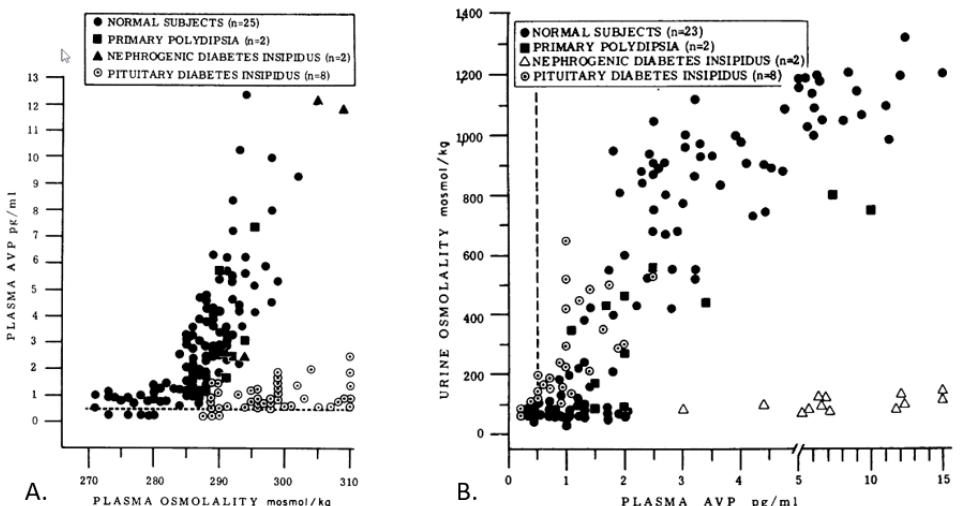
Figure 4. The relationship of plasma osmolality to plasma AVP (panel A), and the relationship of plasma AVP to urine osmolality (panel B). Reprinted with copyright from Robertson et al. [71]. Plasma was collected during recumbent rest in three states of water balance: ad libitum fluid intake, following an acute water load (20 ml/kg), and after acute periods of fluid restriction. The data represent healthy adults and patients with diverse types of polyuria (i.e., abnormally large urine volume and frequency). Dashed lines represent the sensitivity limit of the plasma AVP assay.